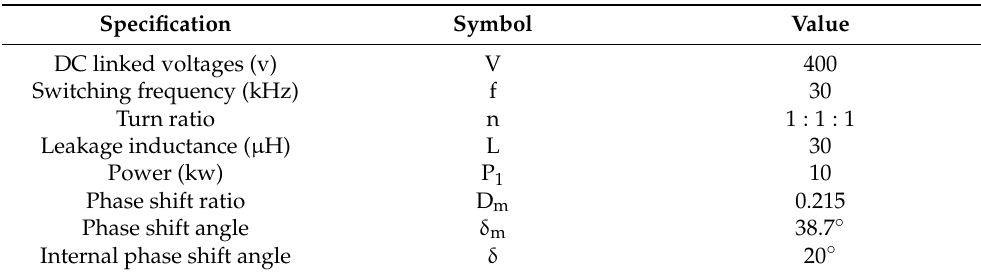
Table 1. Converter Table 1. Converter specifications.